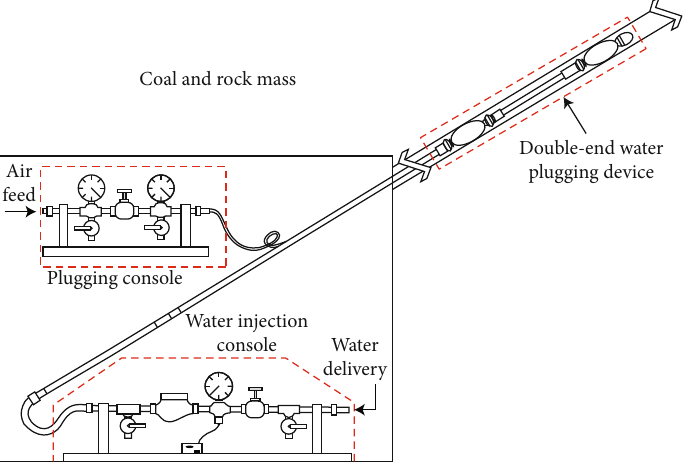
Figure 8: Working principle of observation instrument.